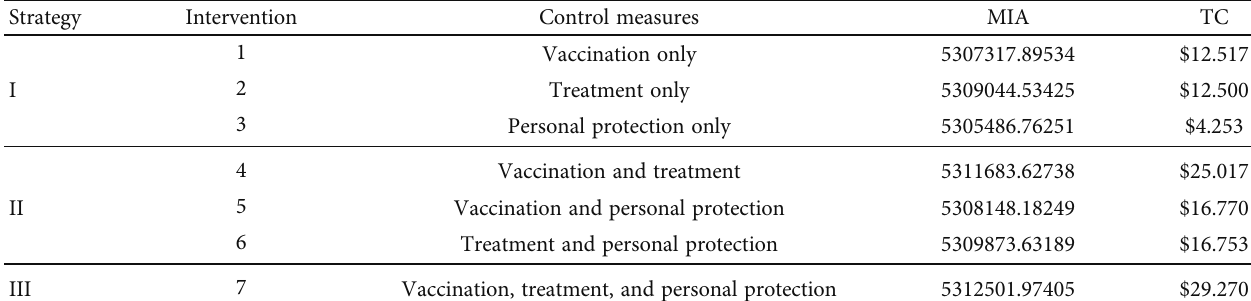
Figure 12: E ff ect of using all controls: vaccination, treatment, and personal protection. For e ff ective meningitis eradication, 80% of individuals must personally protect themselves for 46 days while treatment and vaccination must be implemented for 47 and 50 days, respectively, as shown by the control pro fi le in (a). The graphs clearly show the impact and e ff ectiveness in averting the number of (b) carriers and (c) infected individuals. Table 5: Meningitis infection averted and total cost for the various control